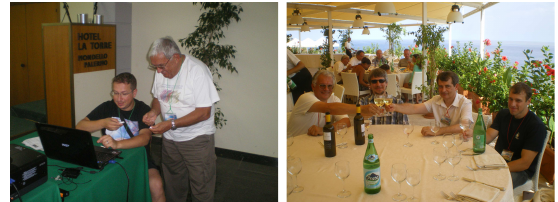
Figure 5: The main conference organizers and key per- sons at action (left) and Russian delegation enjoying the delicious wine of Sicily at the dinner (right).